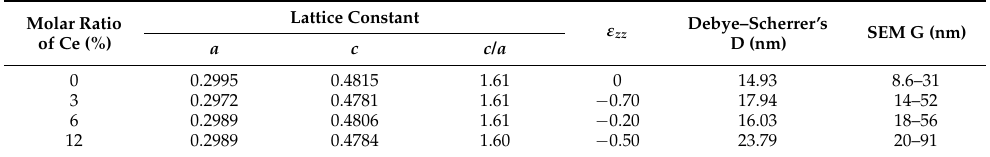
Table 1. Lattice constant and diameter of undoped and Ce-doped ZnO thin film.